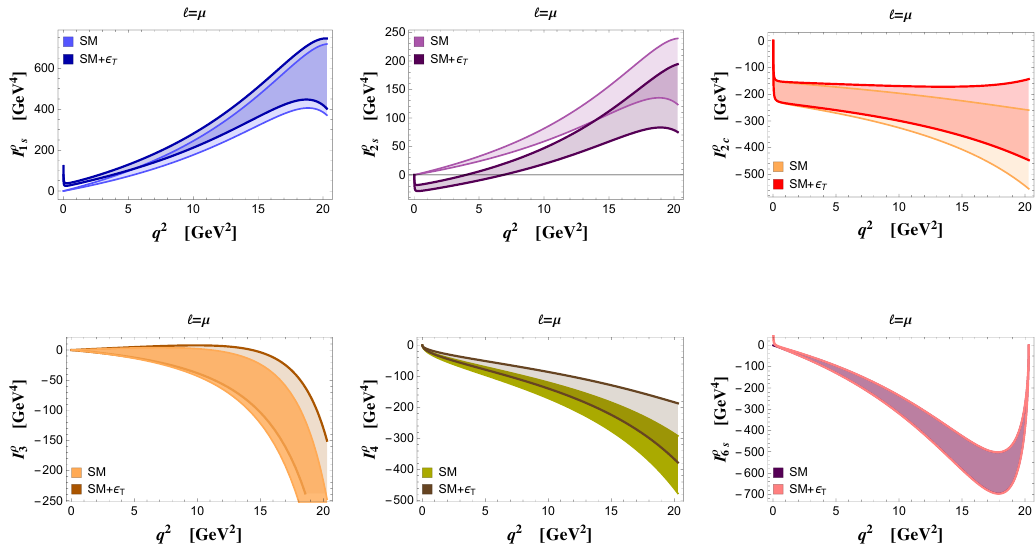
( q 2 ) in Equation (5), for SM and NP at i ( q 2 ) appears in 2 s